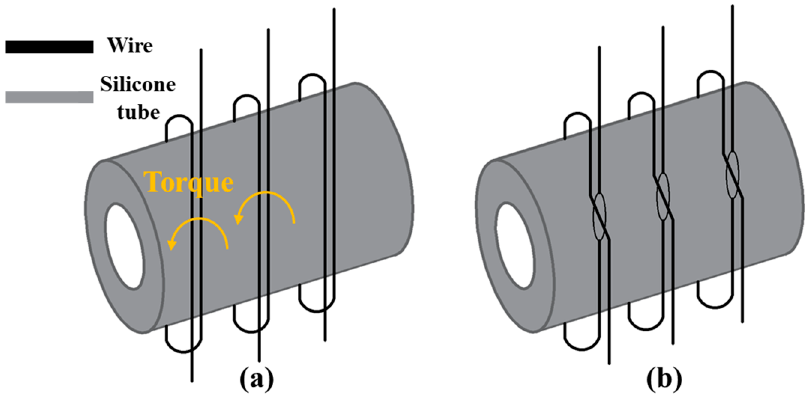
Figure 2. Two patterns of winding ( a ) in same direction ( b ) one end of wire is passed through the gaps between the intertwined wire.